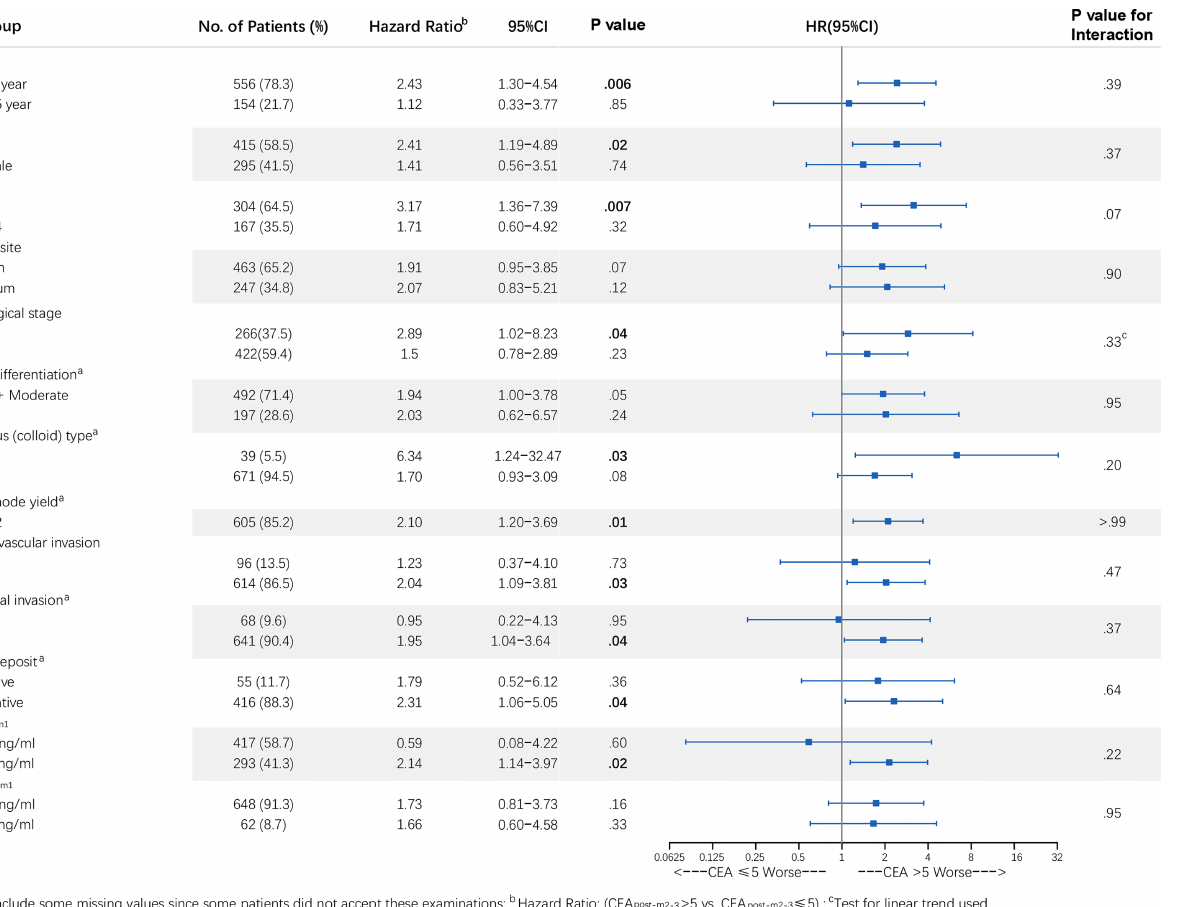
FIGURE 4 | Forest plot of CEA post-m2 – 3 strati fi ed by clinicopathological variables in the primary analysis population. Note: a Includes some missing values since some patients did not accept these examinations; b HR: (CEA >5.0 vs. ≤ 5.0 ng/mL); c Test for linear trend used. P values for interaction were calculated using the Cox regression model. HR and 95% CIs are provided and are visually represented by the squares and error bars. CEA, carcinoembryonic antigen; CEA post-m2 – 3 , serum CEA levels 2 – 3 months after surgery; CI, con fi dence interval; HR, hazard ratio; RFS, recurrence-free